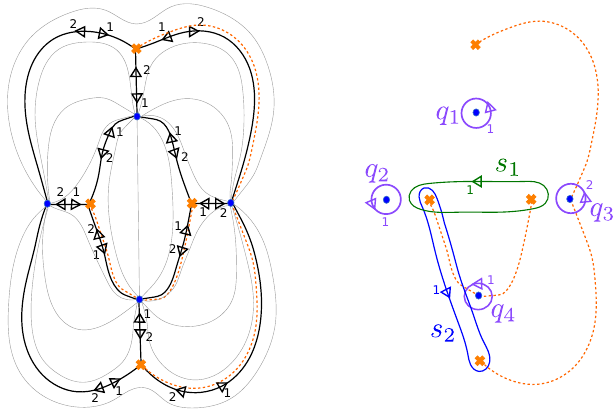
Figure 41 . Left: WKB foliation structure on CP 1 with four punctures (denoted as blue dots) with the parameters in (5.7). Right: a basis f (cid:13) 1 ; (cid:13) 2 ; (cid:22) 1 ; (cid:22) 2 ; (cid:22) 3 ; (cid:22) 4 g for H odd cycles s 1 ; s 2 ; q 1 ; q 2 ; q 3 ; q 4 respectively.